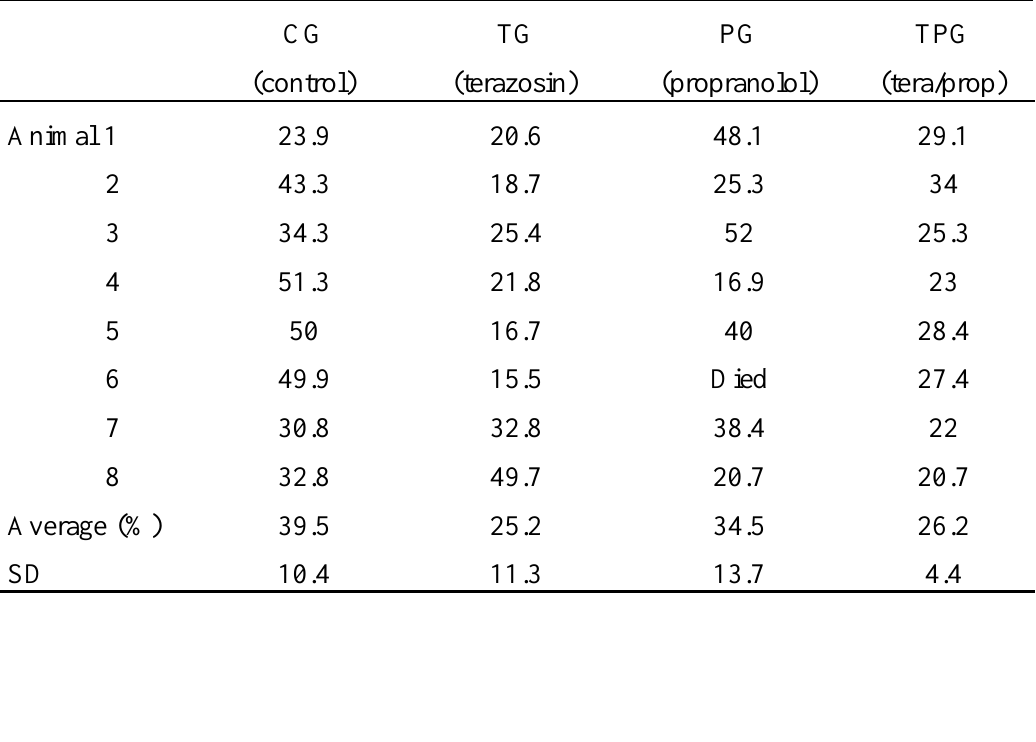
TABLE 1 - Percentage of necrotic area on the seventh postoperative day.